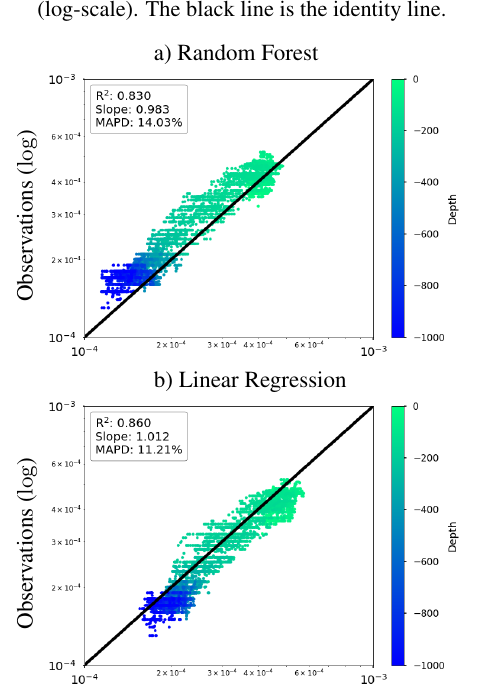
Figure 8. The resulting statistics for the validation float in the South Atlantic Subtropical Gyre (WMO=3902121). The top panel a) shows the results using the Random Forest algorithm and bottom b) the results using the Linear regression. The y-axis are the observations (log-scale) and the x-axis are the predictions (log-scale). The black line is the identity